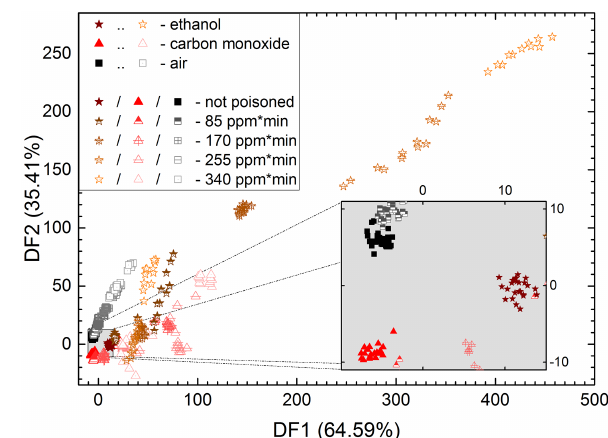
Figure 1. LDA plot showing the discrimination of different gases and data from different poisoning states. The DFs were calculated with data acquired before poisoning (solid symbols), and applied to data from all poisoning states. The 24 features used for this LDA are based on non-normalized conductance